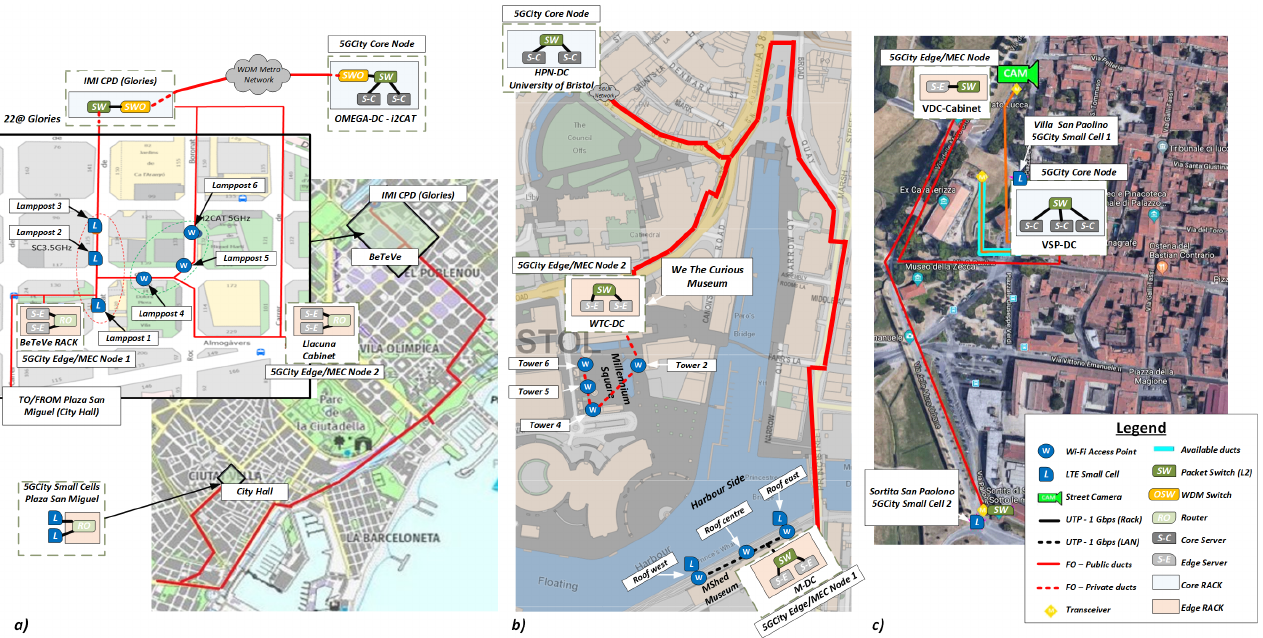
Figure 3. Infrastructure deployed in ( a ) Barcelona, ( b ) Bristol and ( c )